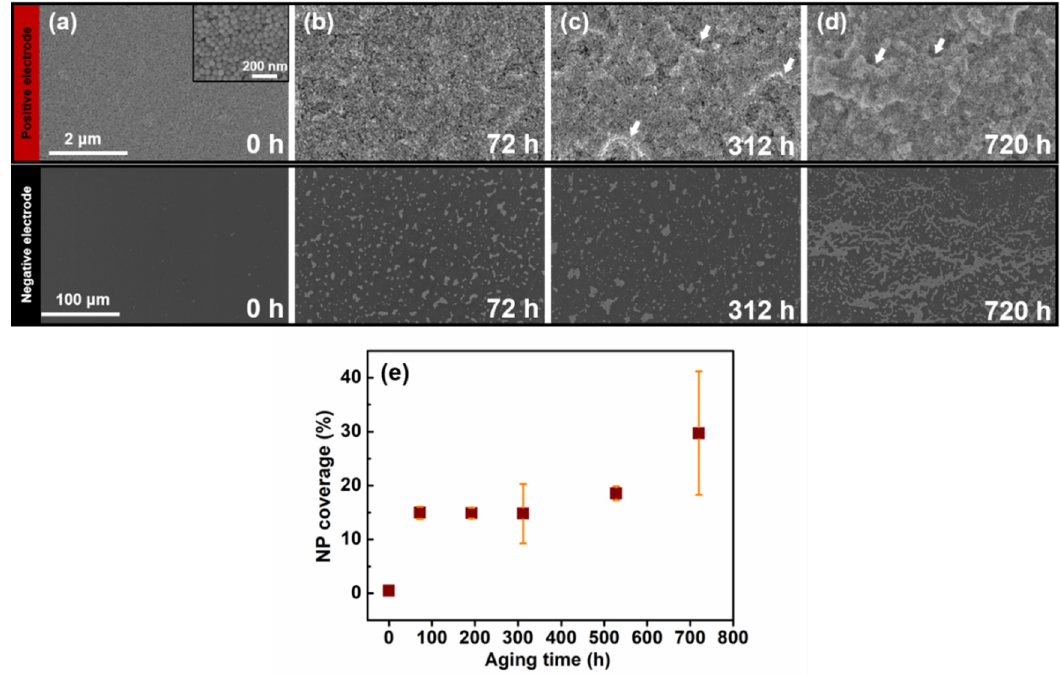
Figure 2. SEM images ( a – d ) of the films fabricated from Cu 2-x S NPs after various aging times (top panel: positive electrode; bottom panel: negative electrode). For the negative electrode, a plot of NP surface coverage against aging time is presented in ( e ).